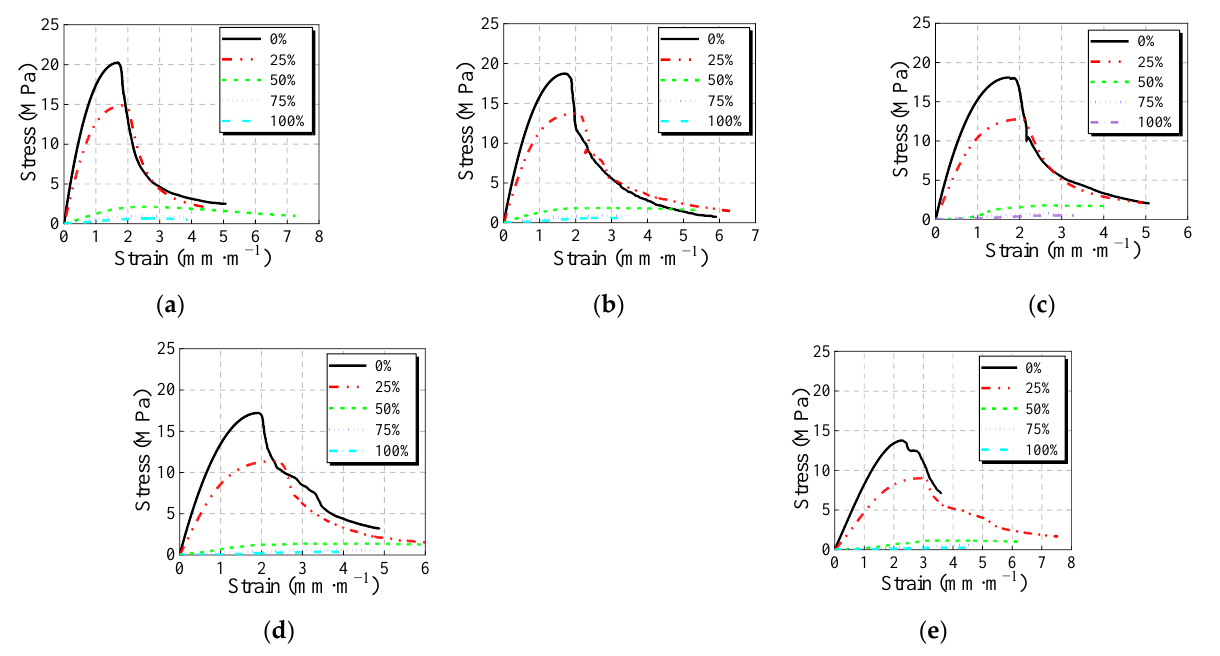
Figure 8. Stress–strain curves with the various jujube nucleus replacement ratio after elevated temperatures. ( a ) T = 20 °C. ( b ) T = 100 °C. ( c ) T = 200 °C. ( d ) T = 400 °C. ( e ) T = 500 °C.